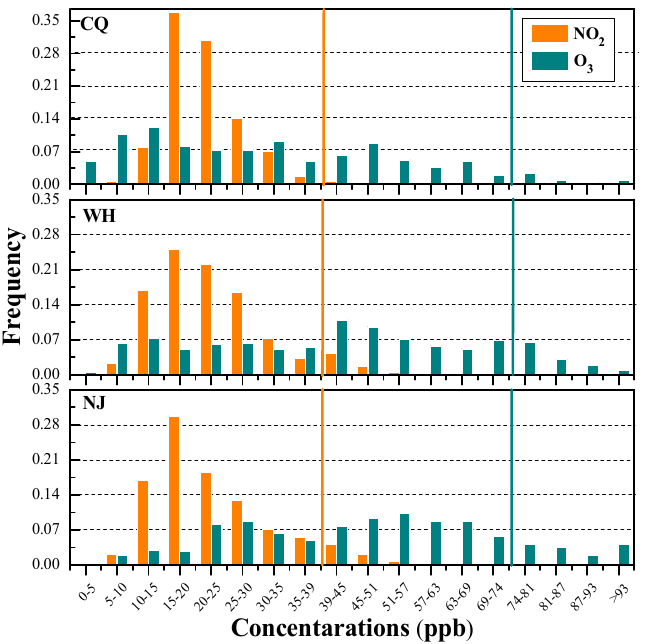
Figure 3. Frequency distributions of daily NO 2 and O 3 -8 h in Chongqing (CQ), Wuhan (WH), and Nanjing (NJ). Note: the CAAQS-II standards of daily average are plotted as straight lines.